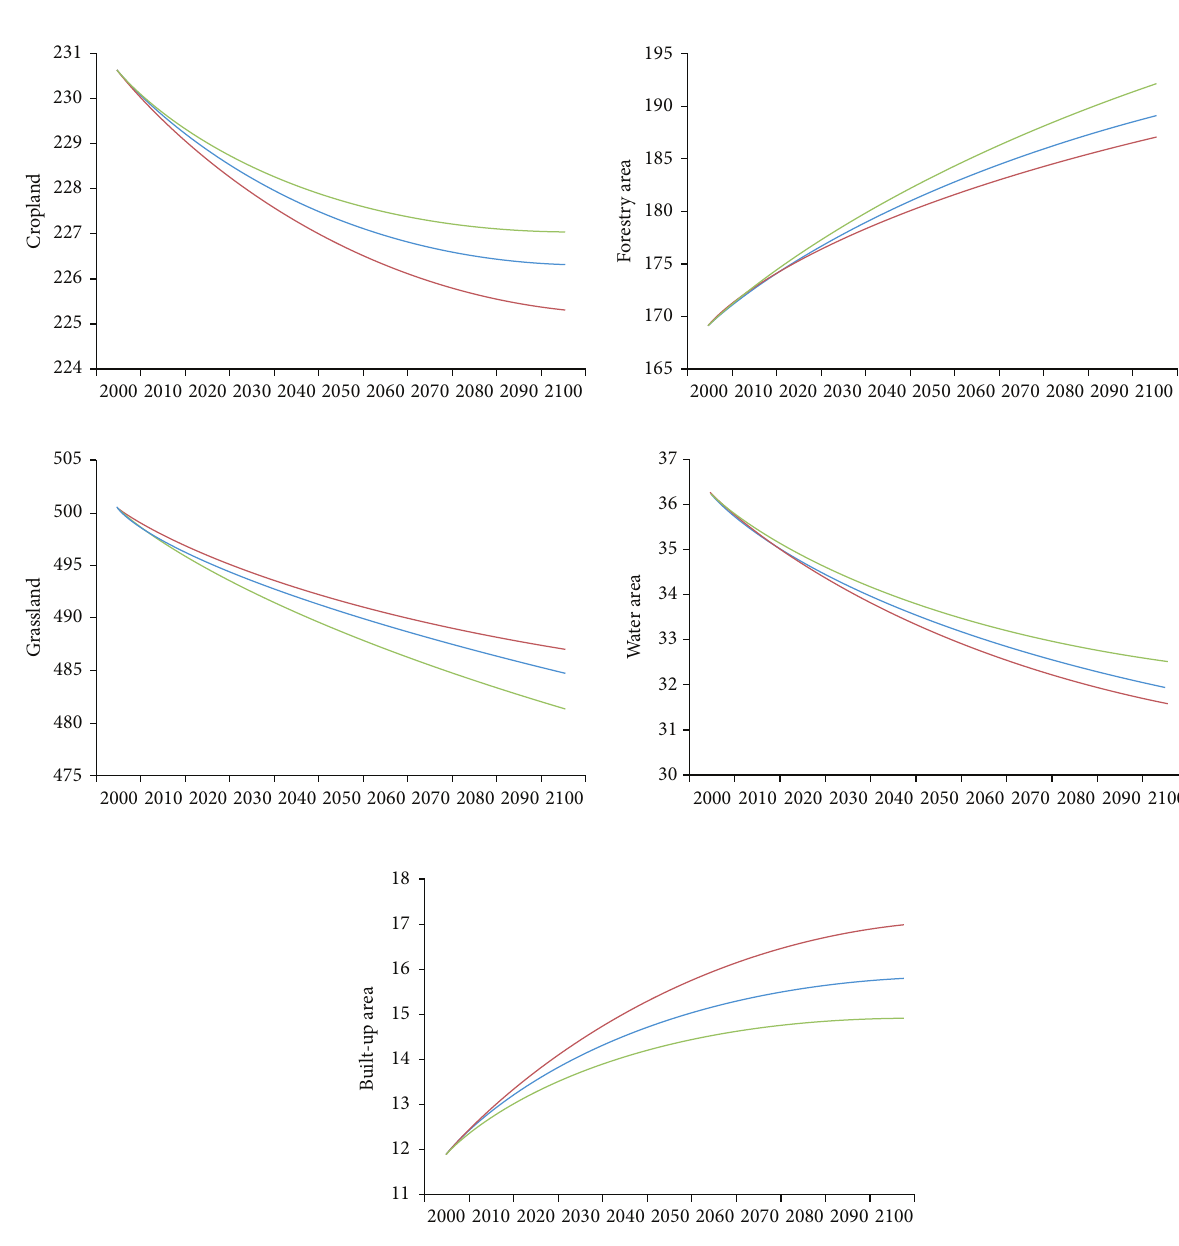
the forestland will be mainly distributed in the regions of hills and